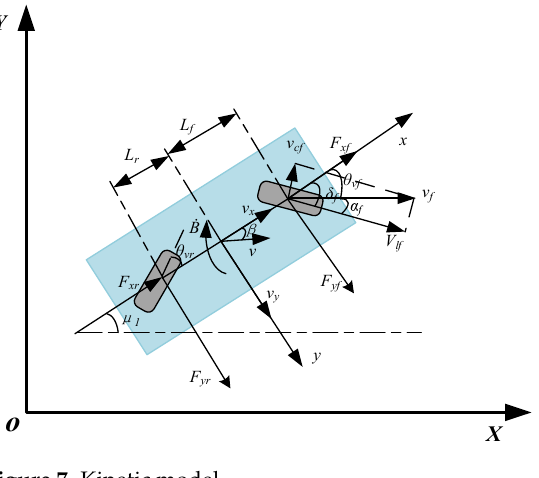
Figure 7. Kinetic model.